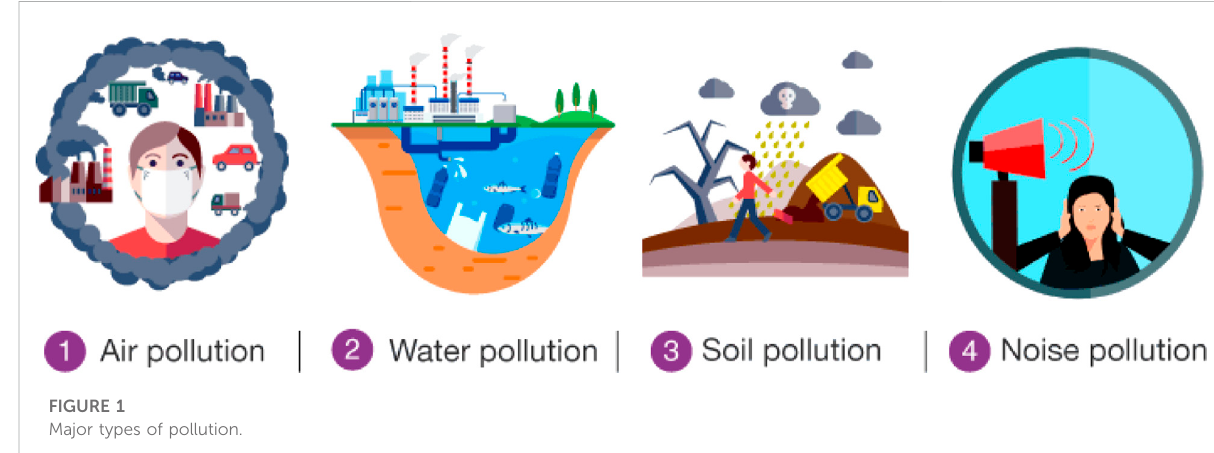
FIGURE 1 Major types of